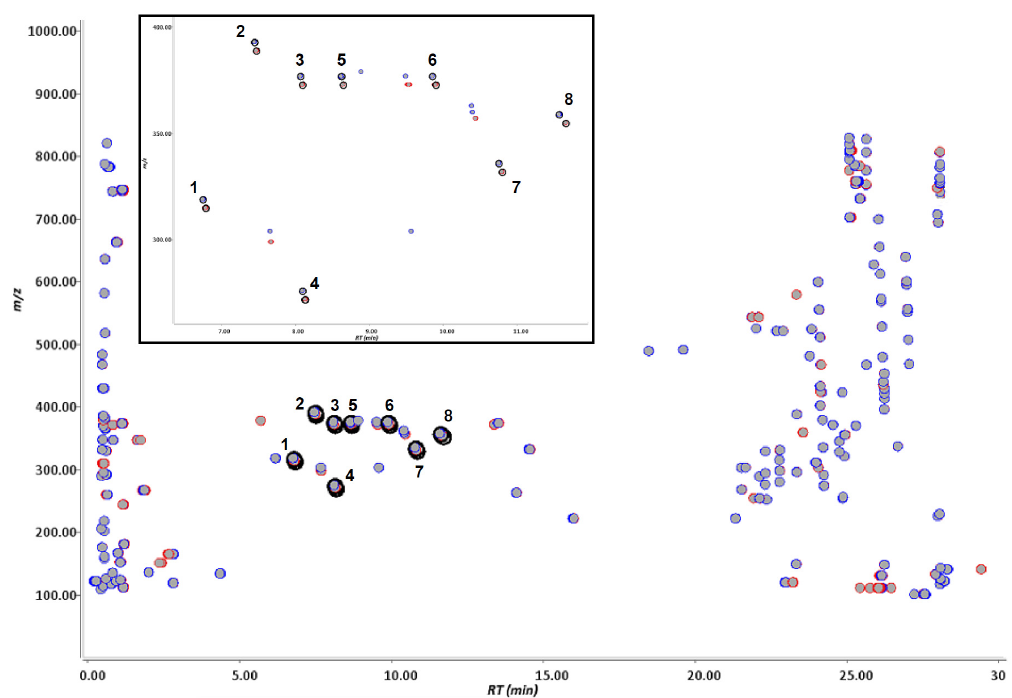
Figure 3. Ions detected by stable isotope mass-shift filtering between deuterium-labeled and un-labeled pioglitazone metabolized in human liver microsomes. The ions derived from un-labeled and labeled pioglitazone are shown by red and blue spots, respectively. By comparing the un-labeled ( red ) and labeled ( blue ) compounds, the particular ions having a specific mass-shift equal to 4 ± 0.04 Da were computationally filtered and visualized by being circled in black. Extended figures of captured ions are shown